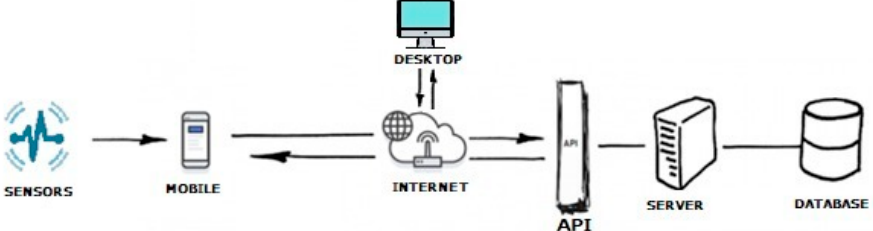
Figure 7. Diagram of the implemented solution to have the signals recorded from the users wearing the gait monitoring physiograph transmitted to a mobile terminal over a Bluetooth radio link and stored into an online database for future retrieval.